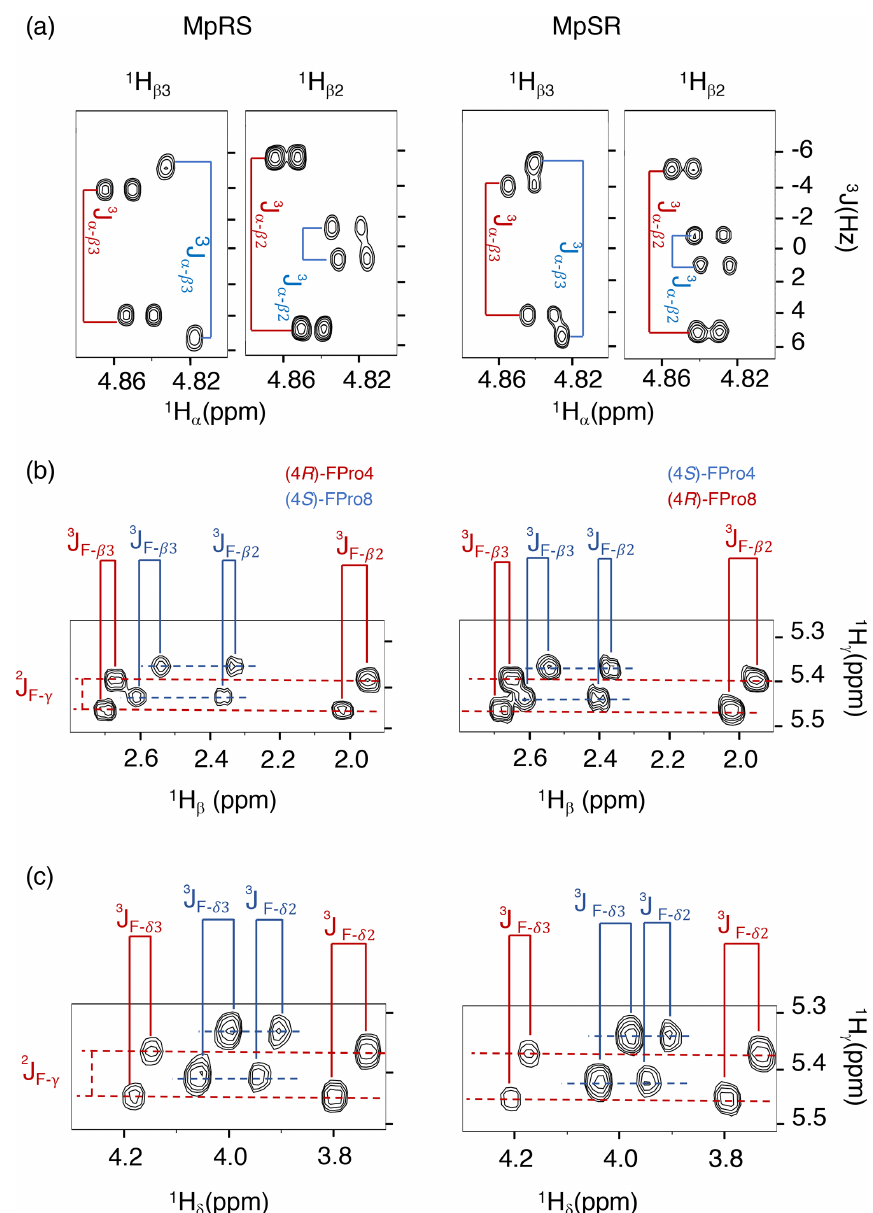
Figure 3. Puckering analysis of fluoroprolines. (a) Homonuclear coupling constants 3 J H α − H β 2 and 3 J H α − H β 3 of the (4 R ) (in red) and (4 S ) (in blue) fluoroprolines in MpSR and MpRS peptides measured from SERF experiments at 298K. (b) The 3 J F − H β heteronuclear coupling constants extracted from 2D 1 H– 1 H TOCSY spectra using the E.COSY cross-peak pattern. (c) The 3 J F − H δ heteronuclear coupling constants extracted from 2D 1 H– 1 H TOCSY spectra using the E.COSY cross-peak